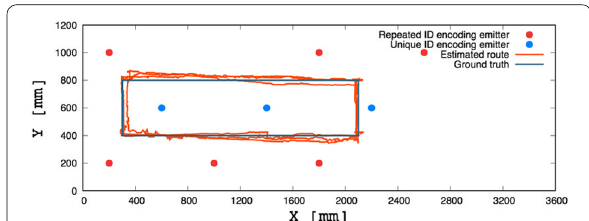
Fig. 11 Result of real-time estimation with the failure of two emitters